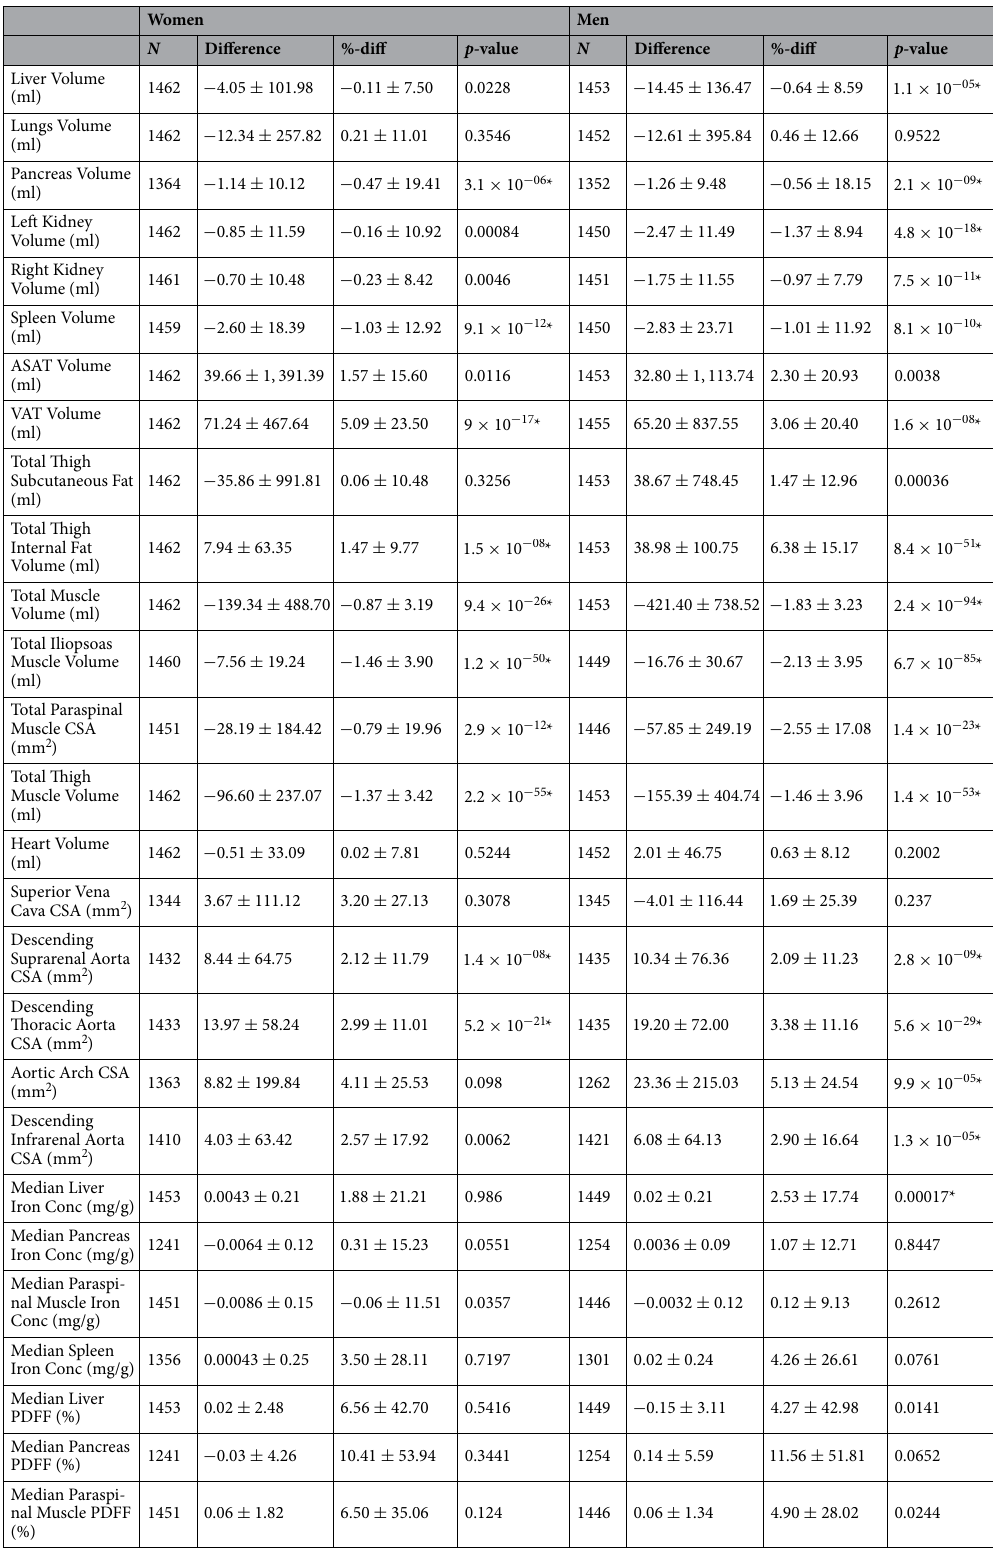
Table 5. Change in IDPs between the first and second imaging visits. Values are reported as mean and standard deviation. An asterisk (*) indicates the p -value is below the significance threshold adjusted for multiple comparisons. ASAT: abdominal subcutaneous adipsose tissue; Conc: concentration; CSA: cross- sectional area; PDFF: proton density fat fraction; VAT: visceral adipose